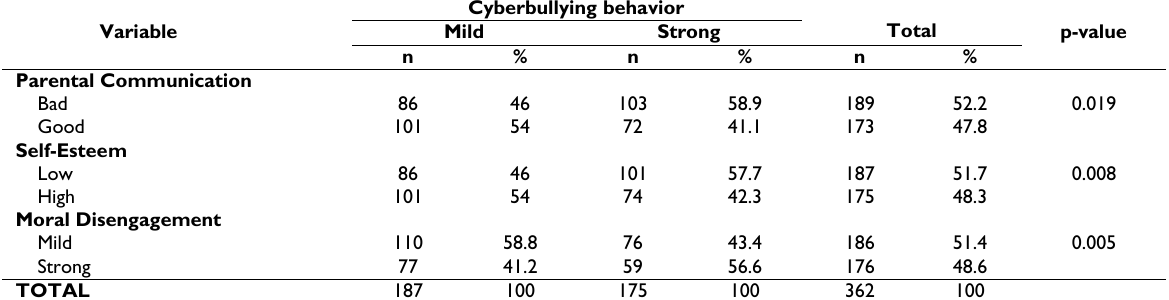
Table 2 Relationship between parental communication pattern, self-esteem, and moral disengagement with cyberbullying behavior (N = 362)